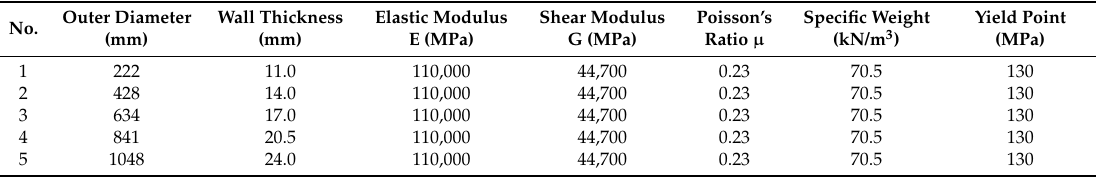
Table 10. Gray cast iron pipes [44,45].